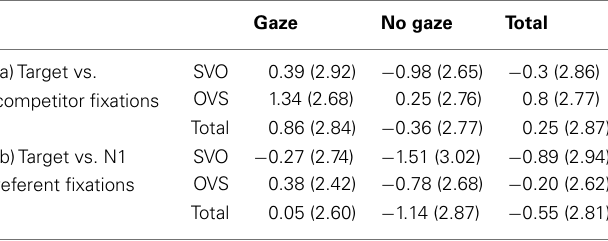
Table 2 | Experiment 1, SHIFT time window: Mean log-gaze probability ratios by condition for fixations to the target character (a) over the competitor or (b) over the NP1